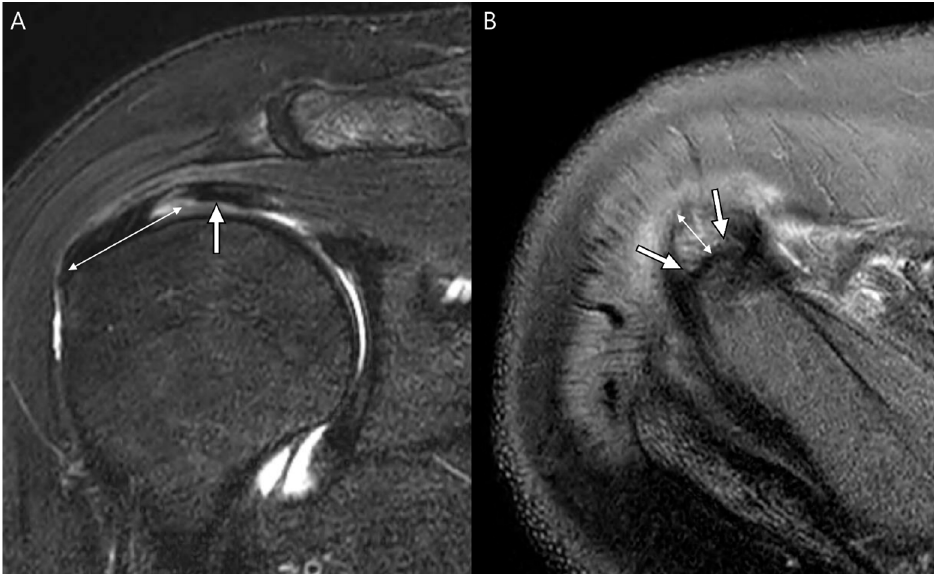
Figure 3. Rotator cable and crescent. ( A ) Oblique coronal fat-suppressed T2-weighted image and ( B ) axial fat-suppressed T2-weighted image demonstrate the low-signal thick bundle of rotator cable (thick arrow) perpendicular to the rotator cuffs and the distal fibers of rotator cuffs from the rotator cable to the greater tuberosity of the humerus called the rotator crescent (arrow bar).